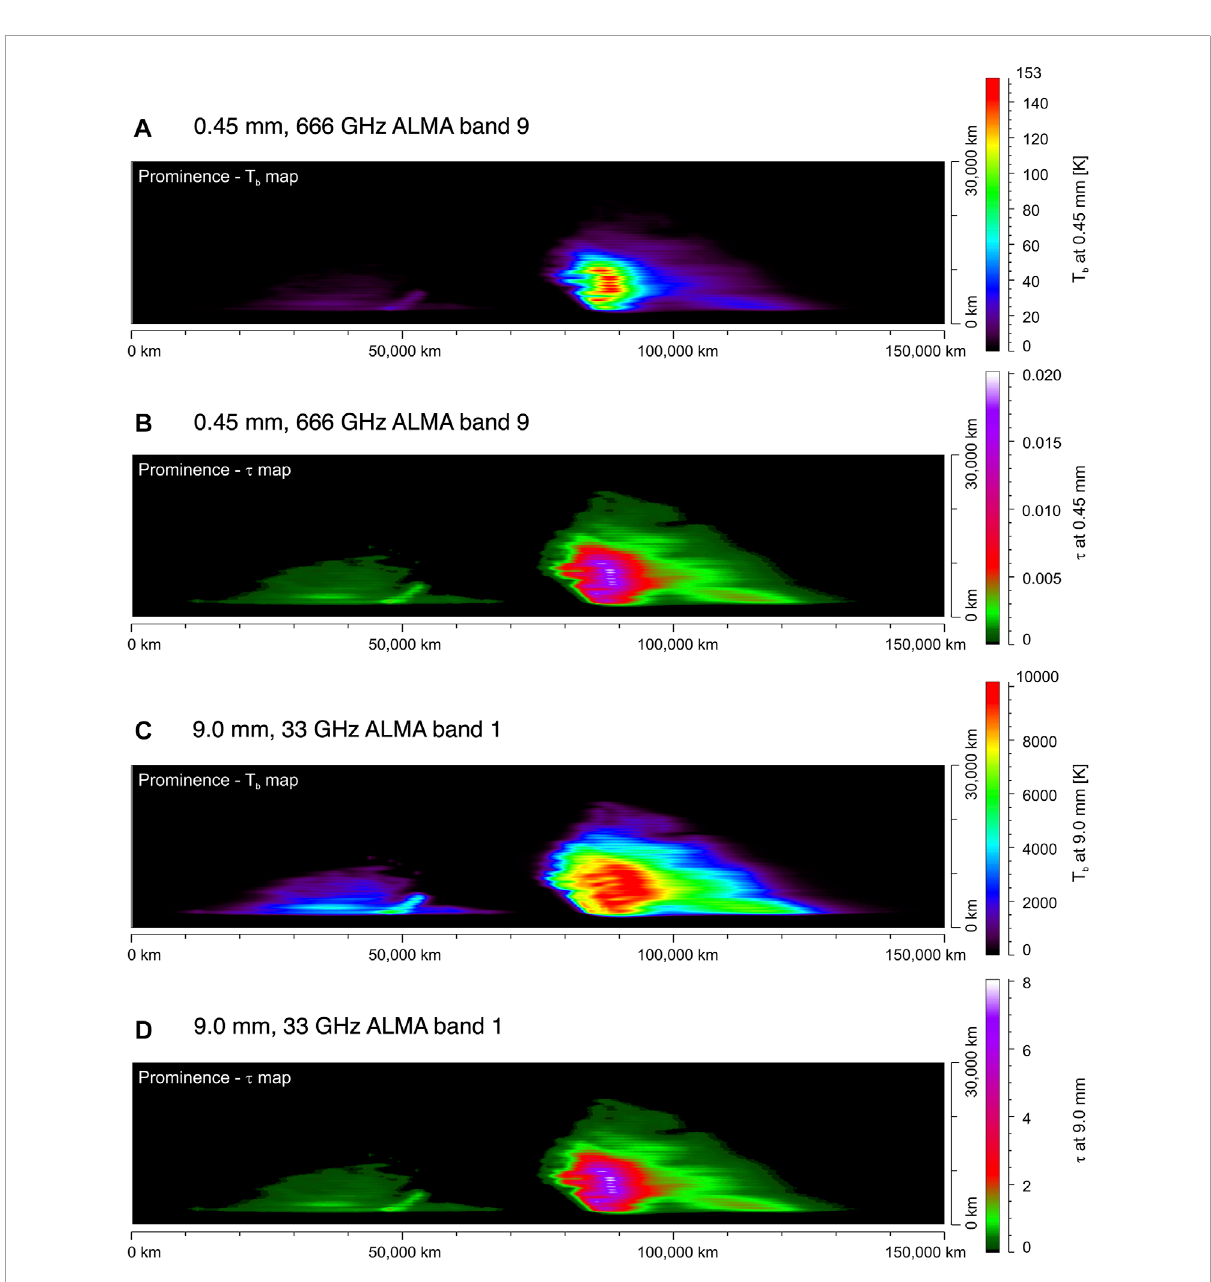
FIGURE 6 Synthetic brightness temperature maps [panels (A, C) ] and optical thickness maps [panels (B, D) ] showing the 3D whole-prominence fine structure model of Gunár and Mackay (2015) in a prominence view. The top two panels were obtained at a wavelength of 0.45 mm, which corresponds to the 666 GHz ALMA band 9. The bottom two panels were obtained at a wavelength of 9.0 mm (33 GHz ALMA band 1). Displayed color scales are unique for each panel. Adapted from Gunár et al.